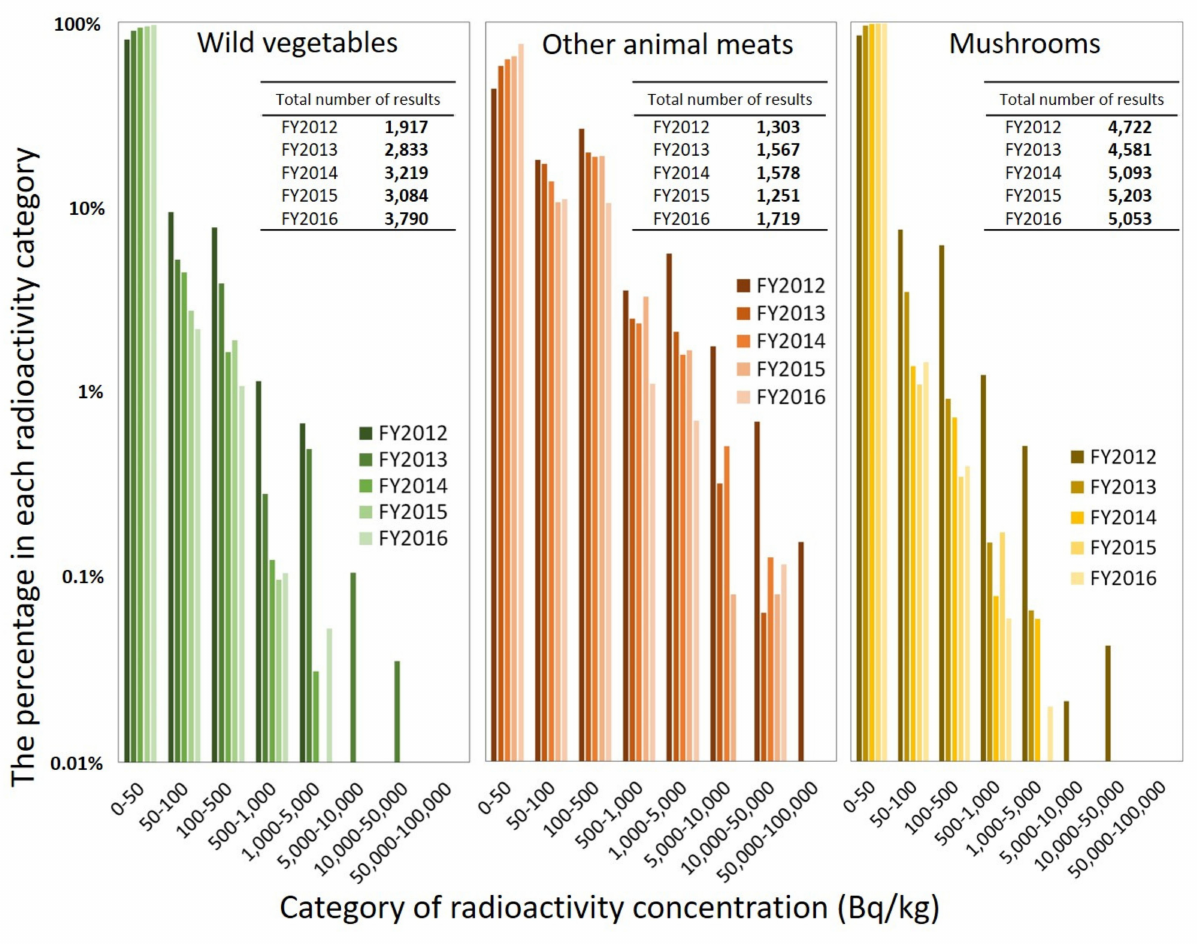
Figure 3. Percentage of monitoring test results for wild vegetables, other animal meats, and mush- rooms in each radioactivity category. As it is often impossible to determine from the test results, natural and cultivated products are counted without distinction. Nonplotted segments (i.e., less than 0.01%) were zero